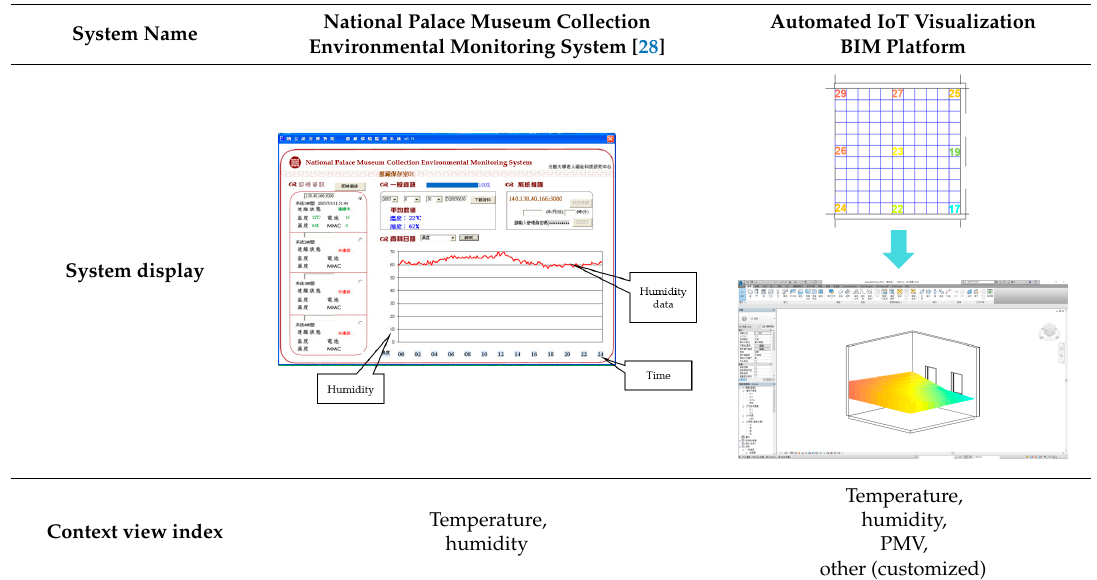
Table 3. Comparison of the results of past case studies and this research project.